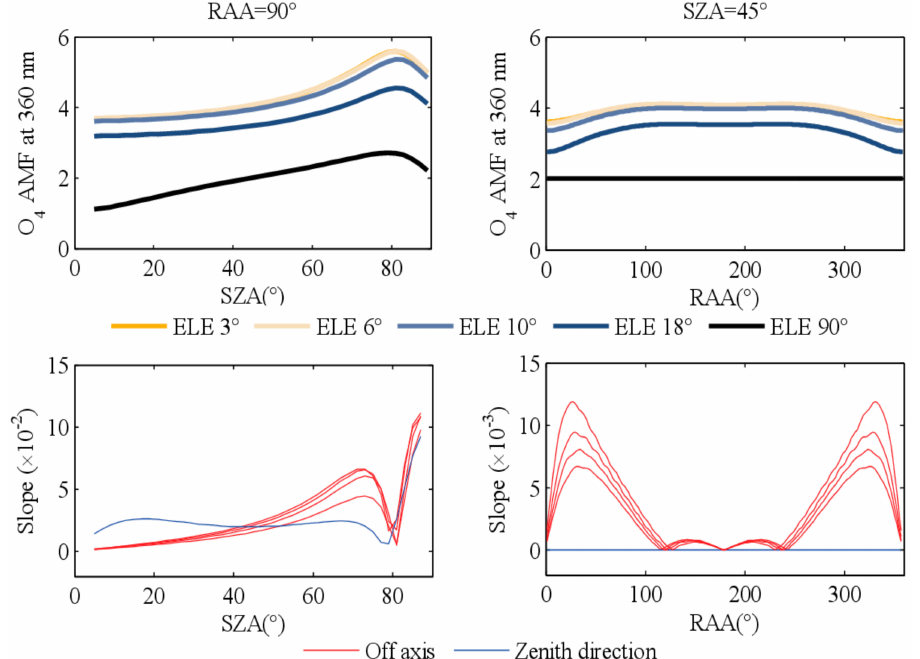
Figure 6. The variation and slope of O 4 AMF with SZA when RAA = 90 ◦ ( left ), and the variation and slope of O 4 AMF with RAA when SZA = 45 ◦ ( right ). The slope graph indicates the slope of the O 4 AMF change with SZA ( left ) and RAA ( right ), where the red lines refer to the off-axis direction and the blue lines indicate the zenith